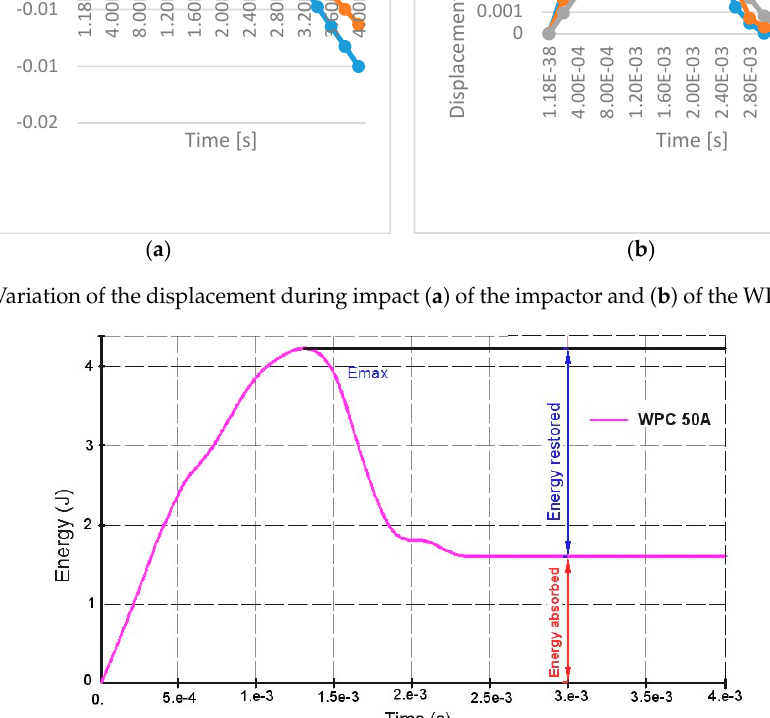
Figure 6. Energy balance during the impact.